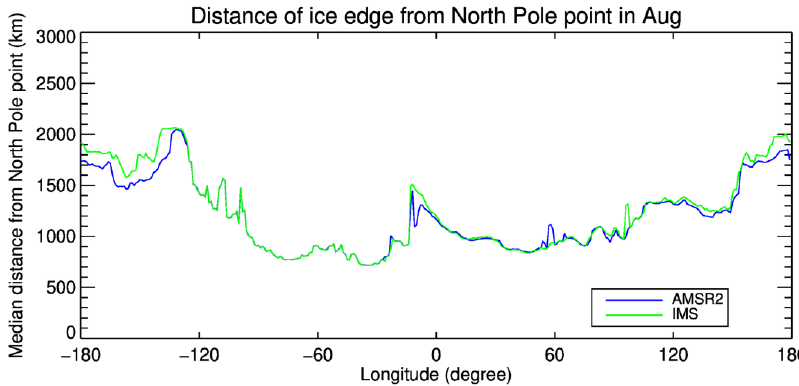
Figure 13. Longitudinal distribution of median ice edge from North Pole point in August from AMSR2 (Blue) and IMS (Green)